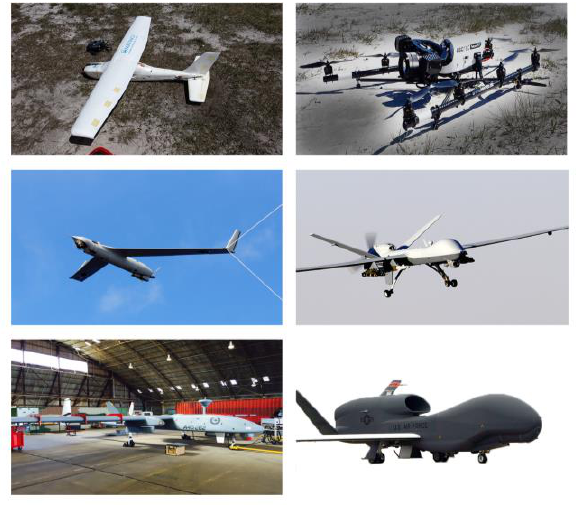
Figure 1- From left to right, top to bottom: MAVinci SIRIUS, AscTec Falcon 8, Boeing Insitu ScanEagle, NASA Ikhana Preditor B, IAI Heron (Machatz-1) courtesy of Royal Australian Air Force (RAAF), Northrop Grumman RQ-4 Global